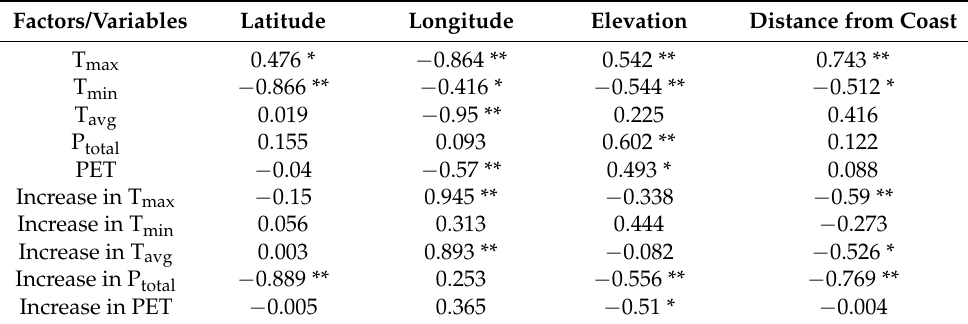
Table 2. Correlation analysis of climate variables (T max , T min , T avg , P total , and PET) and the increases in climate variables (Increase in T max , T min , T avg , and P total from Table S1) and in PET (potential evapotranspiration) with the geographic factors (Latitude, Longitude, Elevation, and Distance from the coast) from the studied 26 wild blueberry fields in Downeast, Maine.